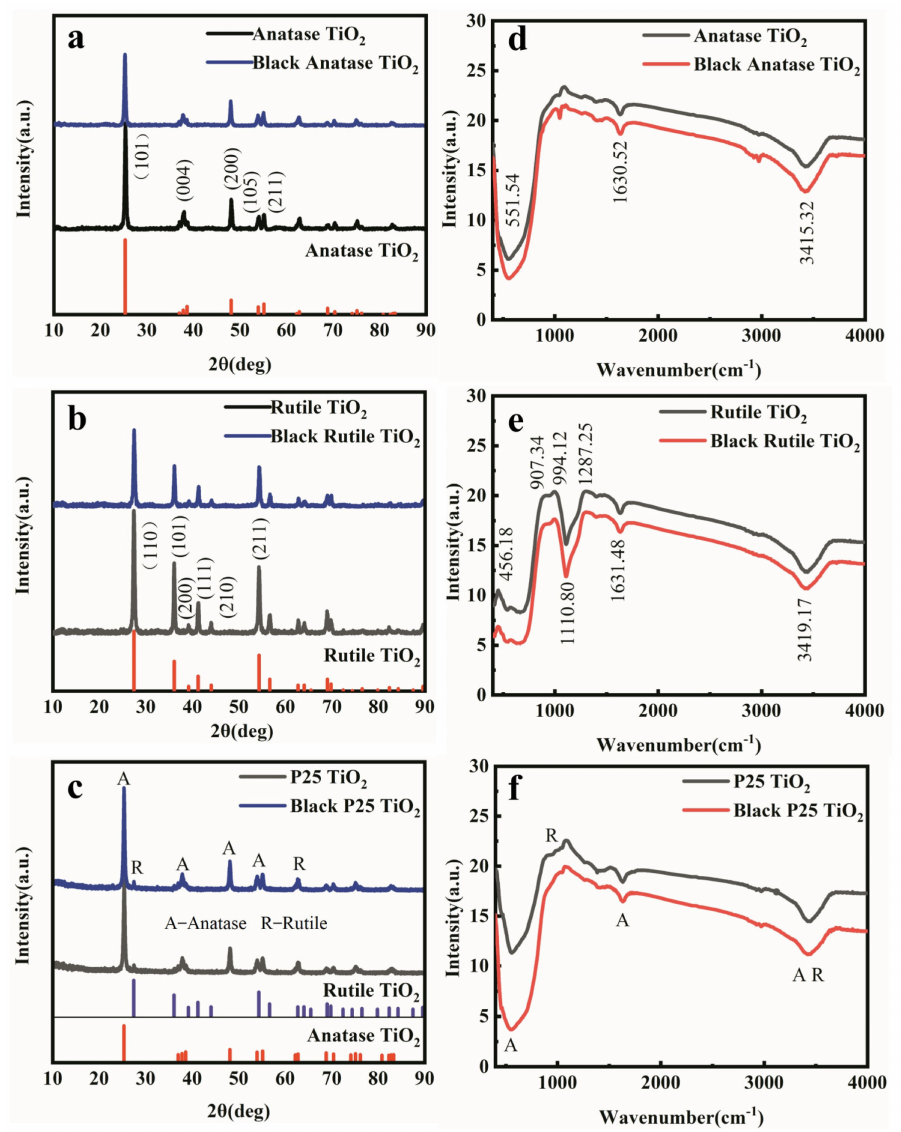
Figure 2. ( a ) XRD patterns of anatase TiO 2 and black anatase TiO 2 ; ( b ) XRD patterns of rutile TiO 2 and black rutile TiO 2 ; ( c ) XRD patterns of P25 and black P25; ( d ) FTIR spectra of anatase TiO 2 and black anatase TiO 2 ; ( e ) FTIR spectra of rutile TiO 2 and black rutile TiO 2 ; ( f ) FTIR spectra of P25 and black P25. A and R in ( c ) and ( f ) represent the peaks from anatase and rutile phases,